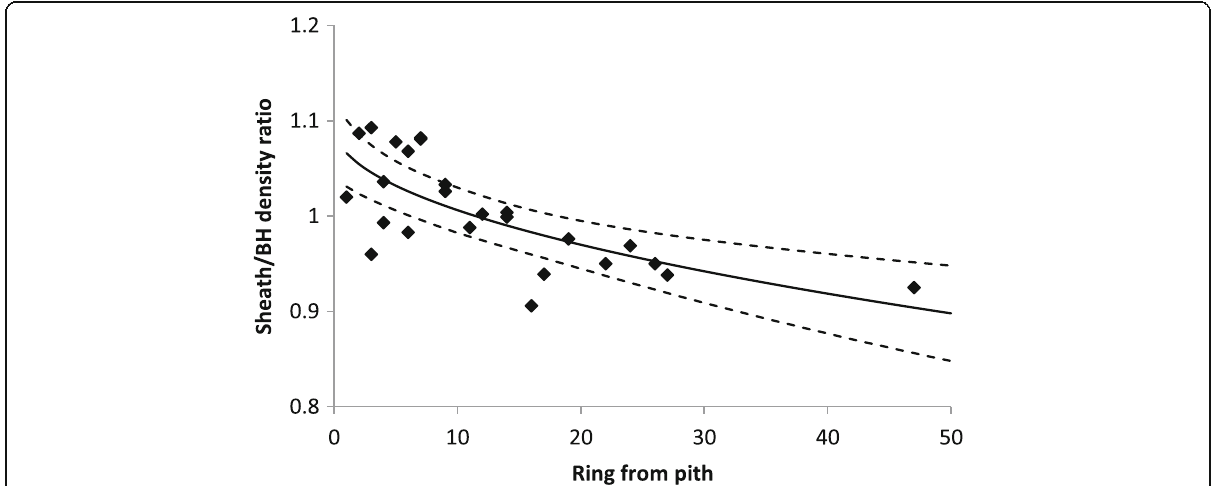
Fig. 2 Relationships between the sheath/BH density ratio and ring number from pith, overlaid with the regression model represented by Eq. 2 and 95% confidence